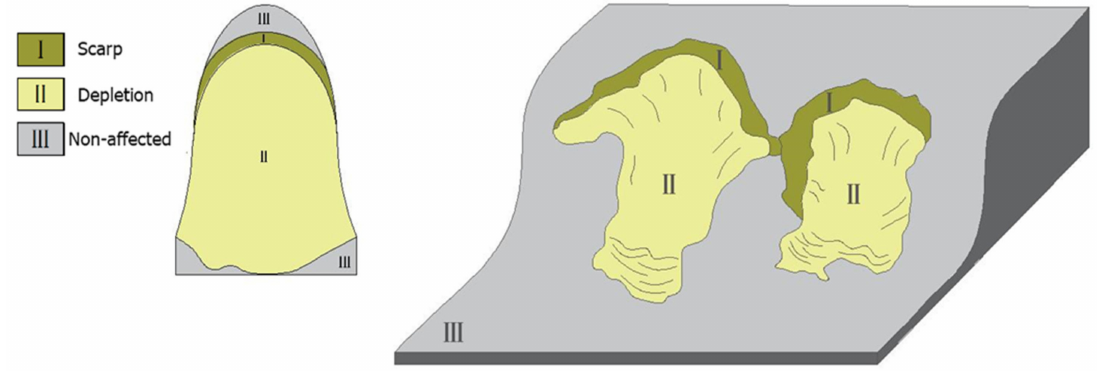
Figure 4. Geomorphological landslide zones used for classification